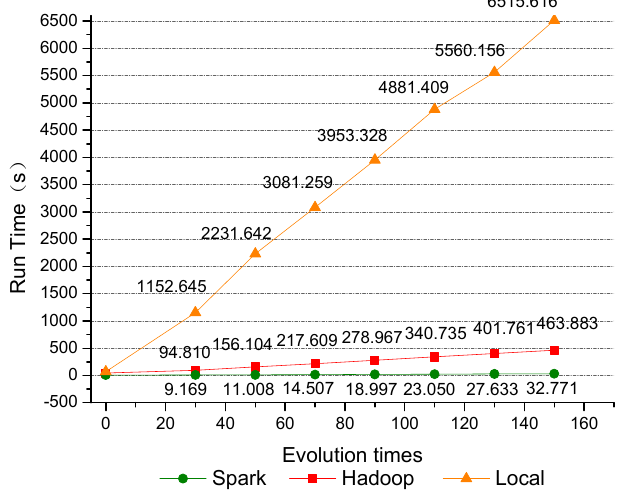
Figure 10. Running efficiency comparison of GAESMPF.